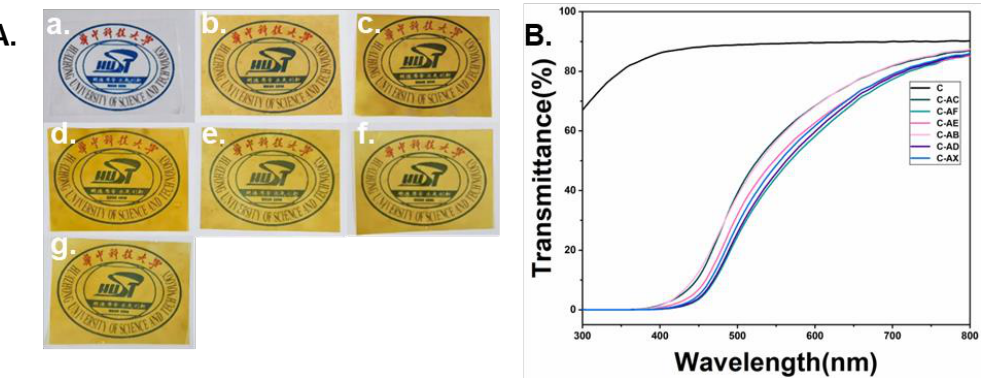
Figure 6. The digital photos ( A ) and the transmittances ( B ) of the collagen-based films. ( a ): collagen film; ( b ): collagen with non-modified APL film; ( c ): collagen with C. echinulate FR3-modified APL film; ( d ): collagen with G. lucidum EN2-modified APL film; ( e ): collagen with P. ostreatus BP3-modified APL film; ( f ): collagen with S. commune DS1-modified APL film; ( g ): collagen with Xylariaceae sp. XY-modified APL film. Table 2. The thickness and color parameters of the collagen-based films.